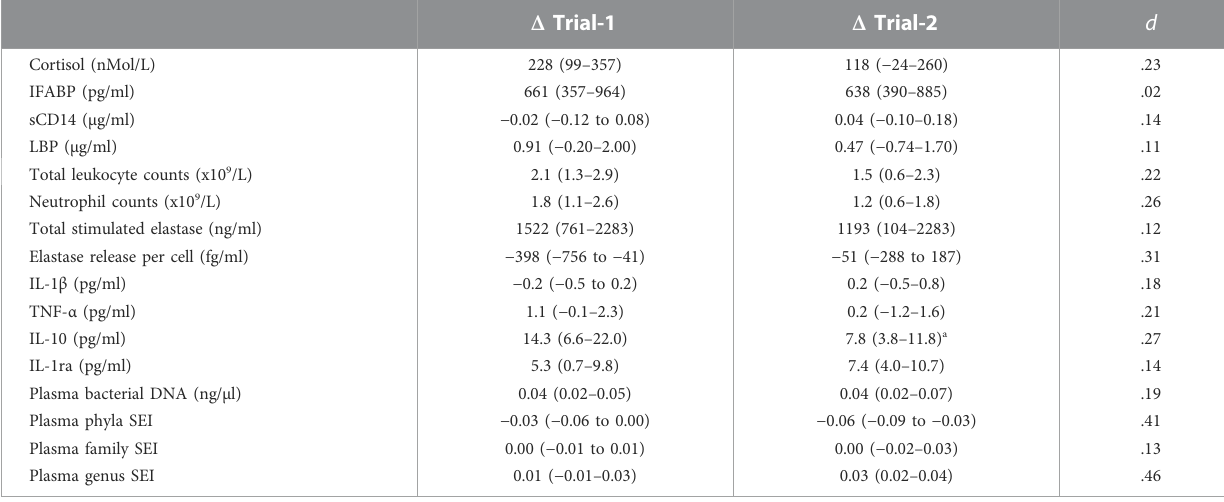
TABLE 3 Pre-to post-exercise magnitude of change in exercise-induced gastrointestinal syndrome (EIGS) biomarkers in response to 2 h high intensity interval exercise in temperate ambient conditions performed on two separate occasions. Δ Trial-1 Δ